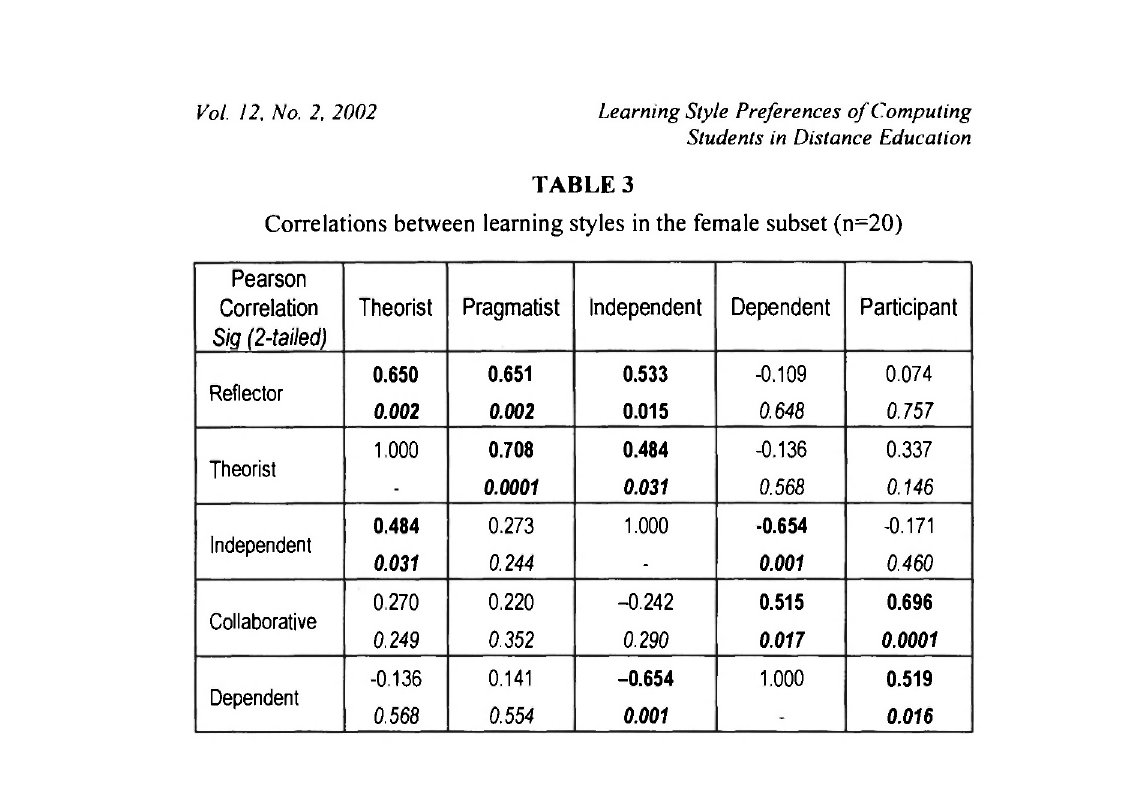
Correlations between learning styles in the male subset (n=25) Pearson Correlation